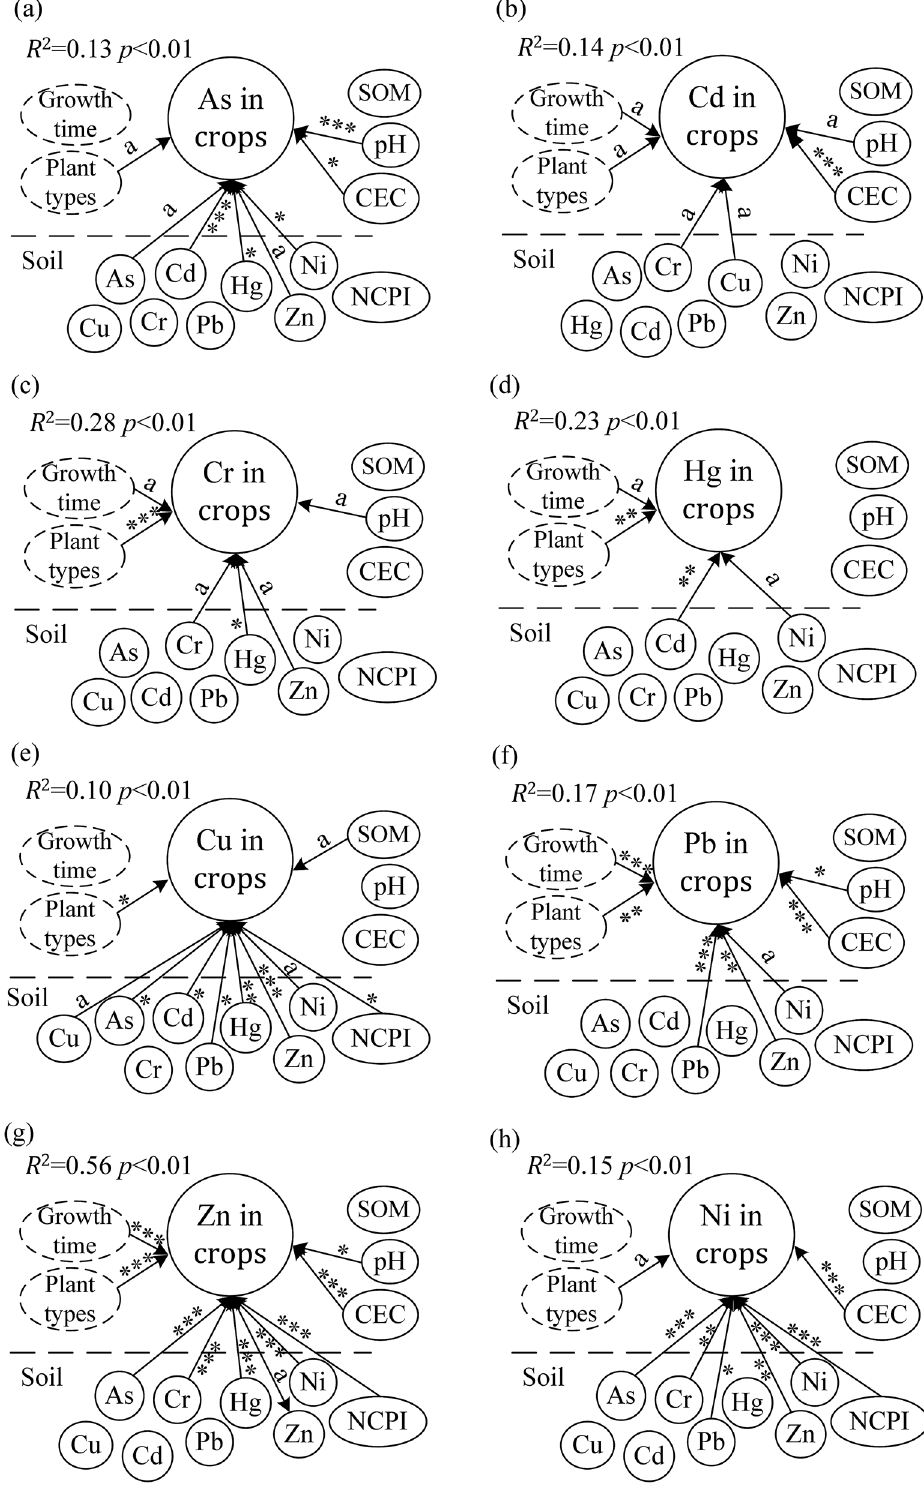
Figure 3. The relationships of soil trace elements, soil physicochemical properties, plant types and growth time against trace elements in crop calculated using generalized linear models (GLM). Arrows indicate that the factors have significant effects on trace elements in crops. *** p < 0.001; ** p < 0.01; * p < 0.05; a p <